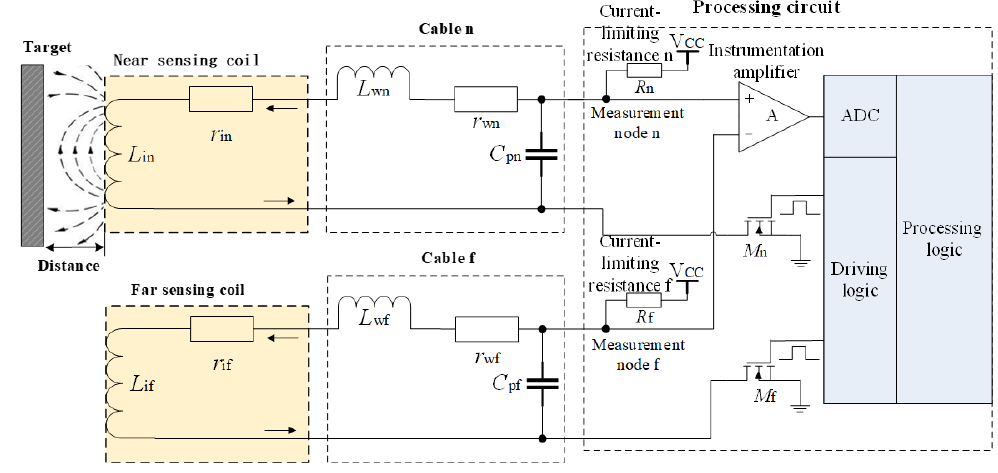
Figure 3. Block diagram of differential structured IPS.